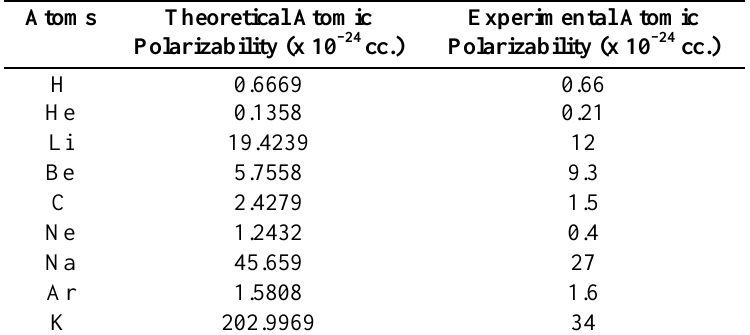
Table 8. Comparative study of theoretical and experimental atomic polarizability of some